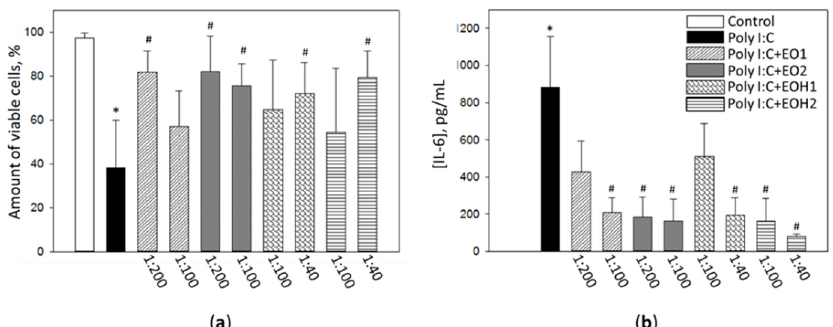
Figure 2. The effect of nutmeg seed essential oil ethanol solutions and the essential oil hydrolats on Poly I:C-treated human fibroblast cell viability ( a ) and cytokine IL-6 release from the cells ( b ). EO1— essential oil without the excipient solution, EO2—essential oil with 1% magnesium